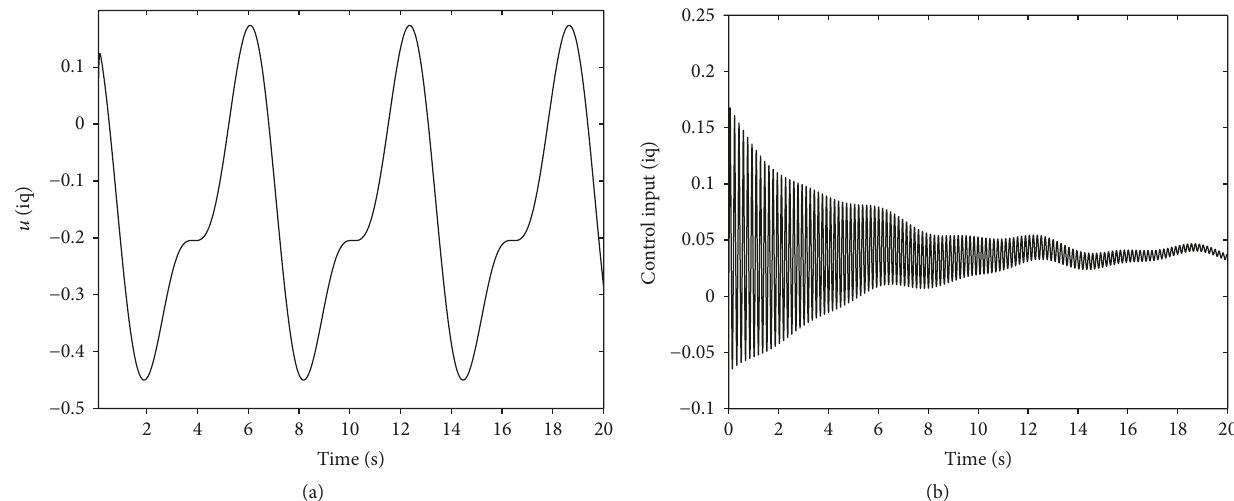
Figure 5: The output values of di ff erent control methods in the nominal model case: (a) the control output of MBIC and (b) the control output of NBIC.